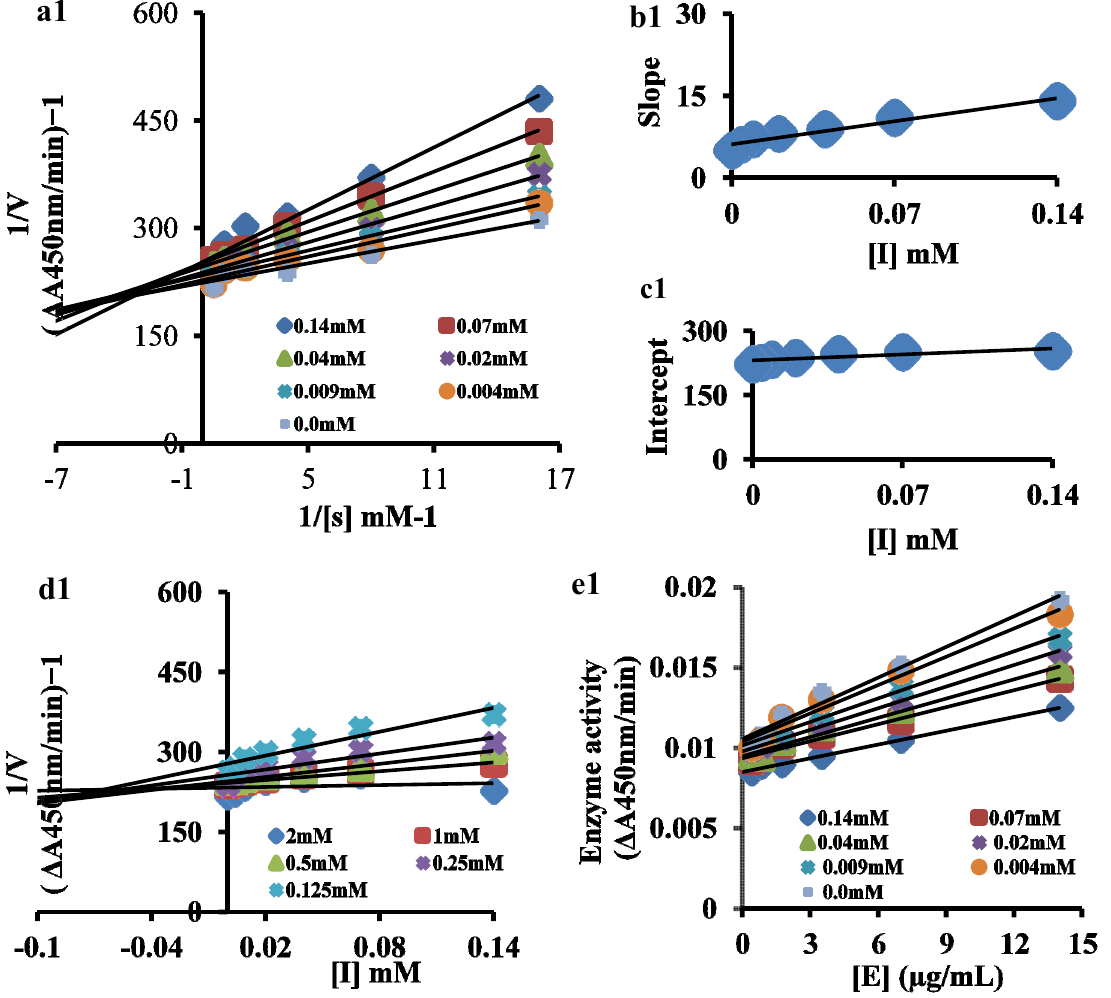
Figure 3. ( a1 ) Lineweaver–Burk plot for inhibition of tyrosinase enzyme in the presence of various concentrations of enoxacin sesquihydrate (as indicated) and L-DOPA concentrations (0.0625, 0.125, 0.25, 0.5, 1 mM and 2 mM). ( b1 ) The insets represent the plot of the slope from Lineweaver–Burk plot versus inhibitor. ( c1 ) The secondary replot of the Lineweaver–Burk plot, 1/ V (y-intercept) versus various concentrations of inhibitor. ( d1 ) The Dixon plot of the reciprocal of the initial velocities versus various concentrations of the test drug. ( e1 ) Relationship between the catalytic activity of tyrosinase and various concentrations of the test drug.